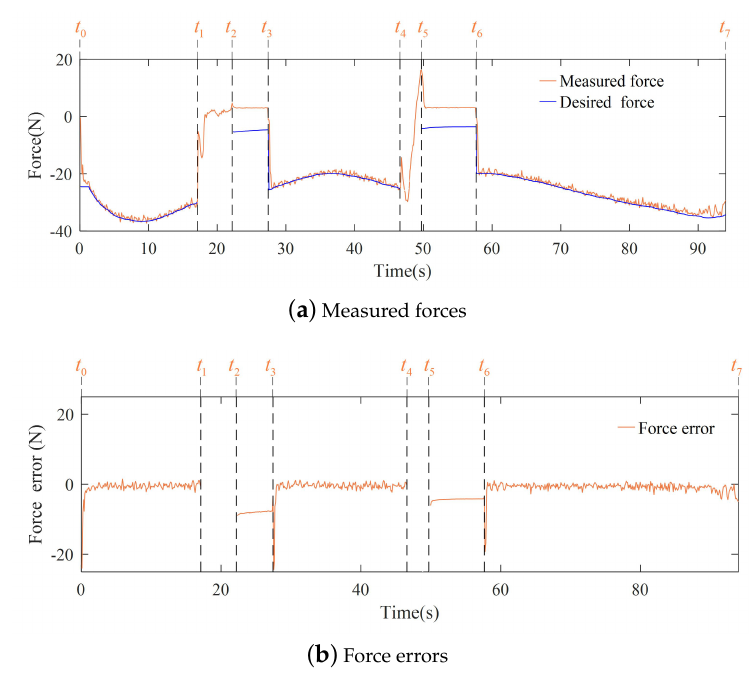
Figure 15. Measured force and force errors of robot executing a contact task under